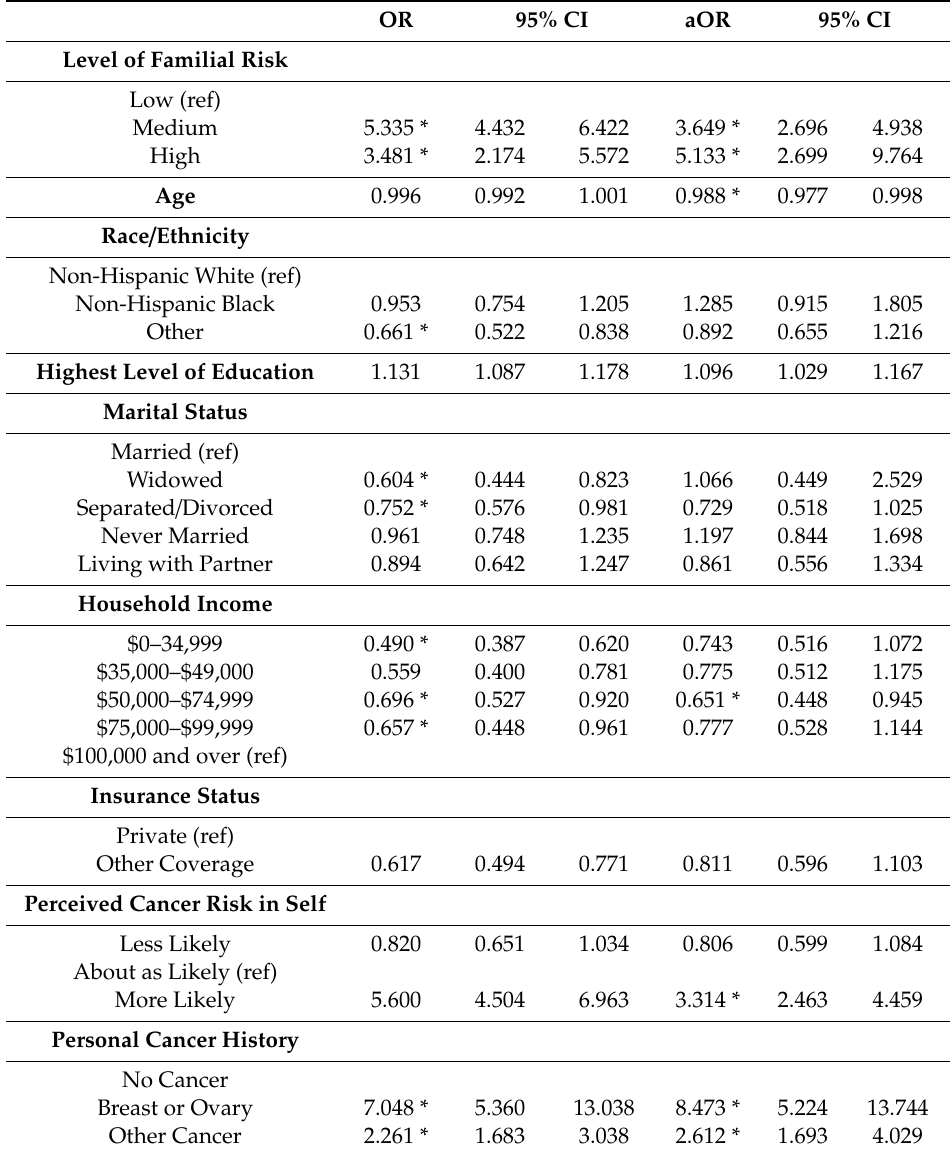
Table 3. Associations with Discussed Genetic